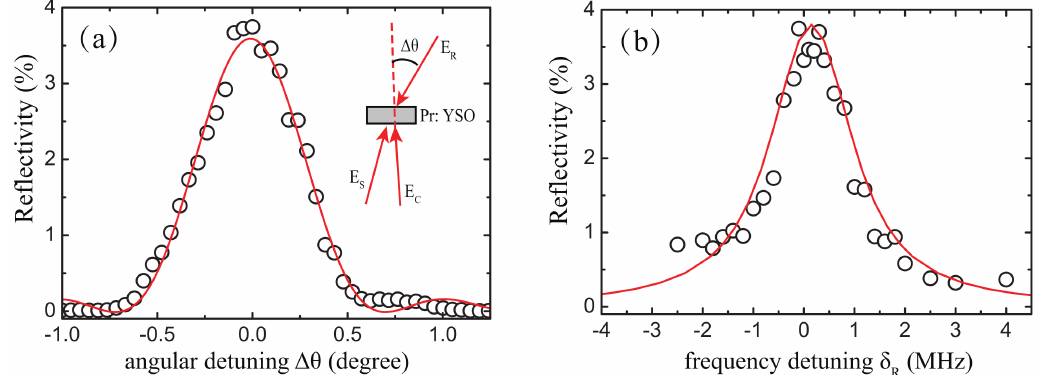
Figure 3. The angular and spectral selectivity of the atomic coherence grating in a 3-mm Pr:YSO crystal. The open circles are the experimental results, and the red solid curves are the theoretical fits using Equation (4), where the reflectivity is defined as the energy ratio of the retrieved signal pulse to the incident signal pulse. ( a ) shows the angular rocking curve of the atomic coherence grating, while ( b ) depicts the spectral rocking curve of the atomic coherence grating. The reflectivity was measured by launching the readout beam in the opposite direction with respect to the coupling beam (see the inset in ( a )), and its frequency was matched to that of the signal pulse to satisfy the phase matching condition. ∆ θ is the angular detuning deviated from the phase matching condition, δ R is the frequency detuning with respect to the central frequency of the signal pulse. Figure adapted from reference